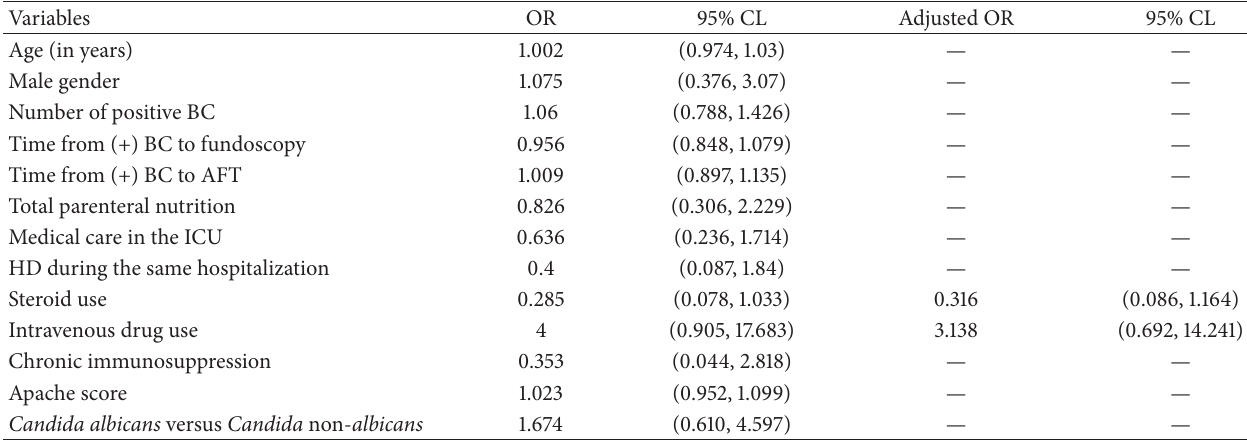
Table 3: Odds ratio of factors associated with ocular candidiasis ( 𝑛 = 144